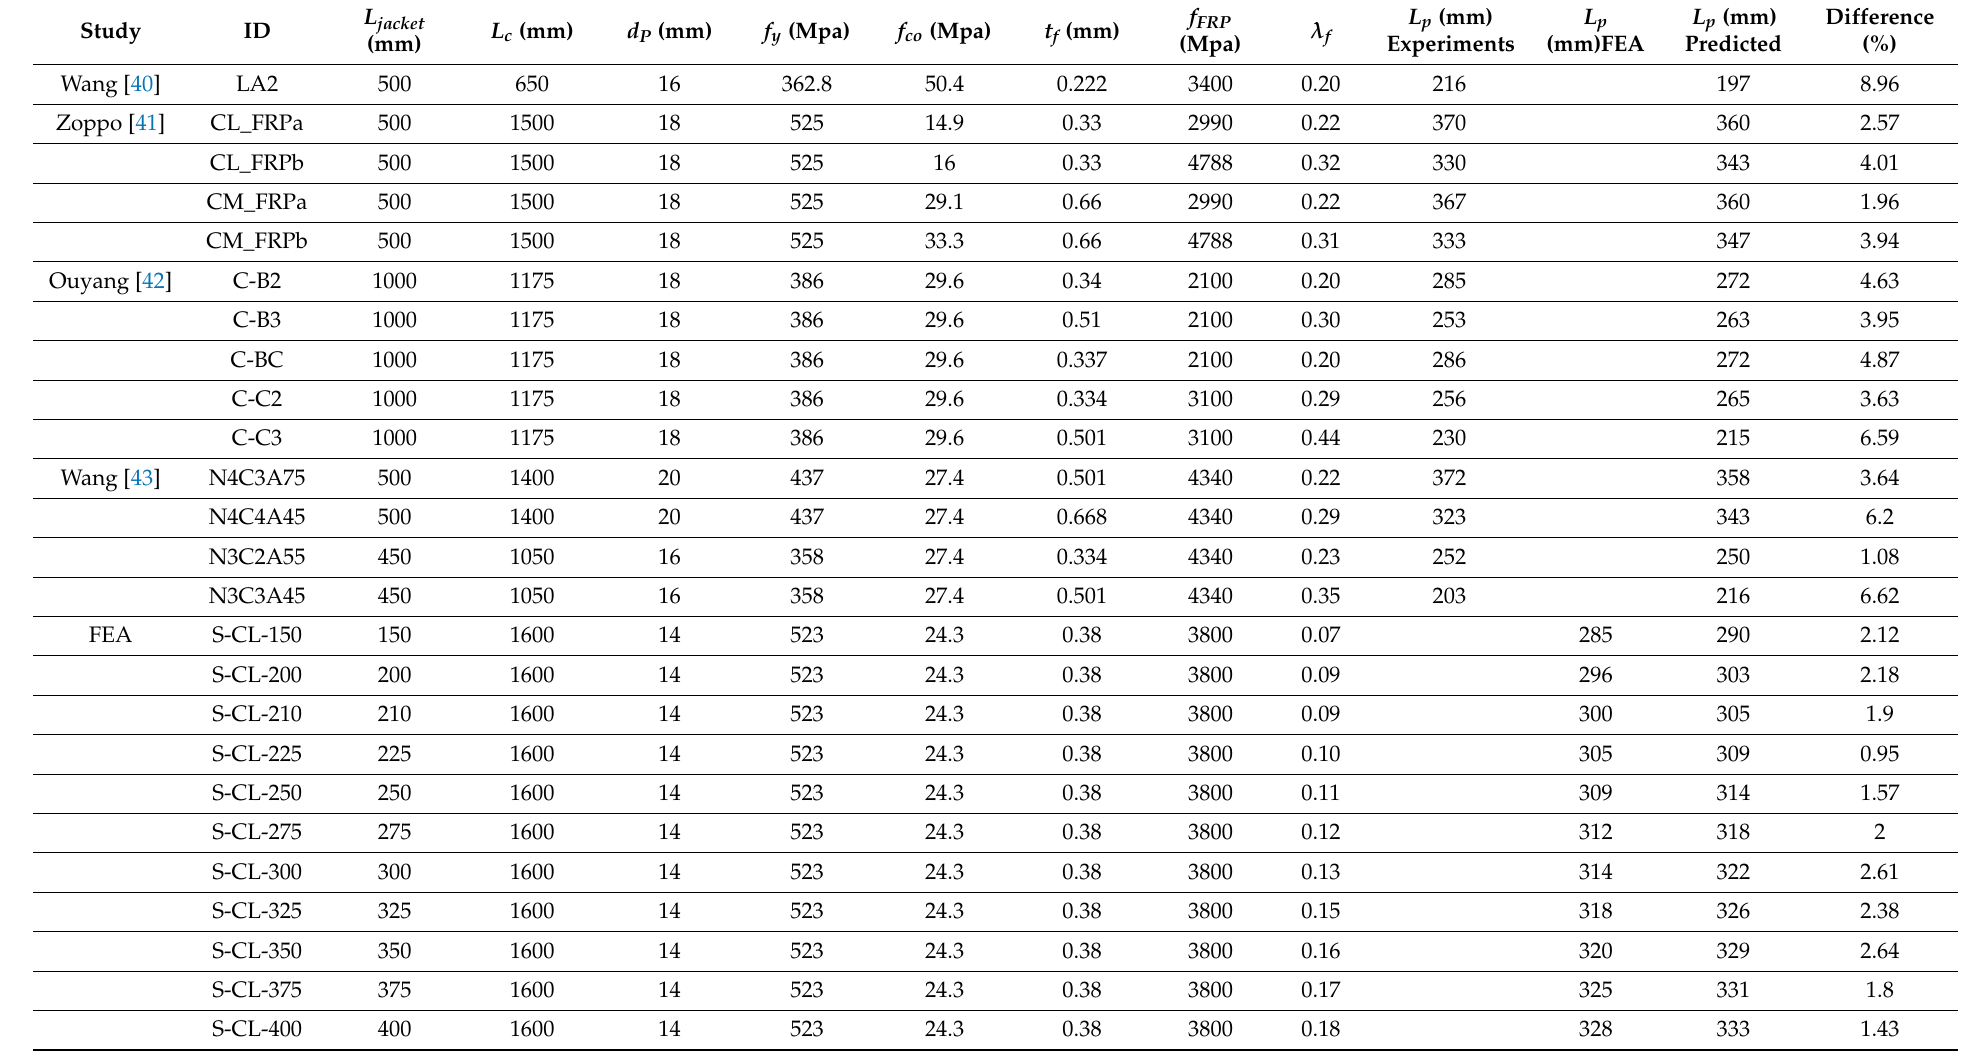
Table 7. Results of Columns from Experimental Work in the Literature [40–43] and Present Numerical